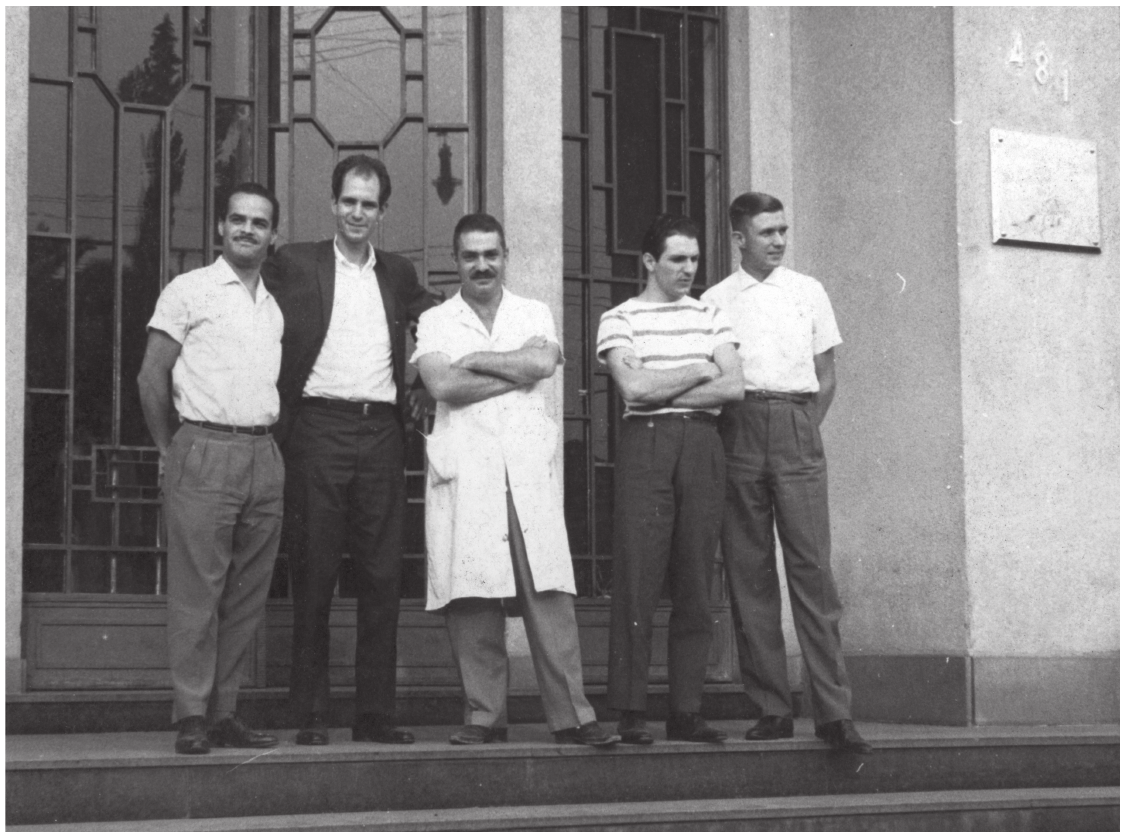
Fig. 2. From left to right: Naércio Menezes, Jonathan Baskin, Paulo Vanzolini, Almenor Tacla and Hans Reichardt